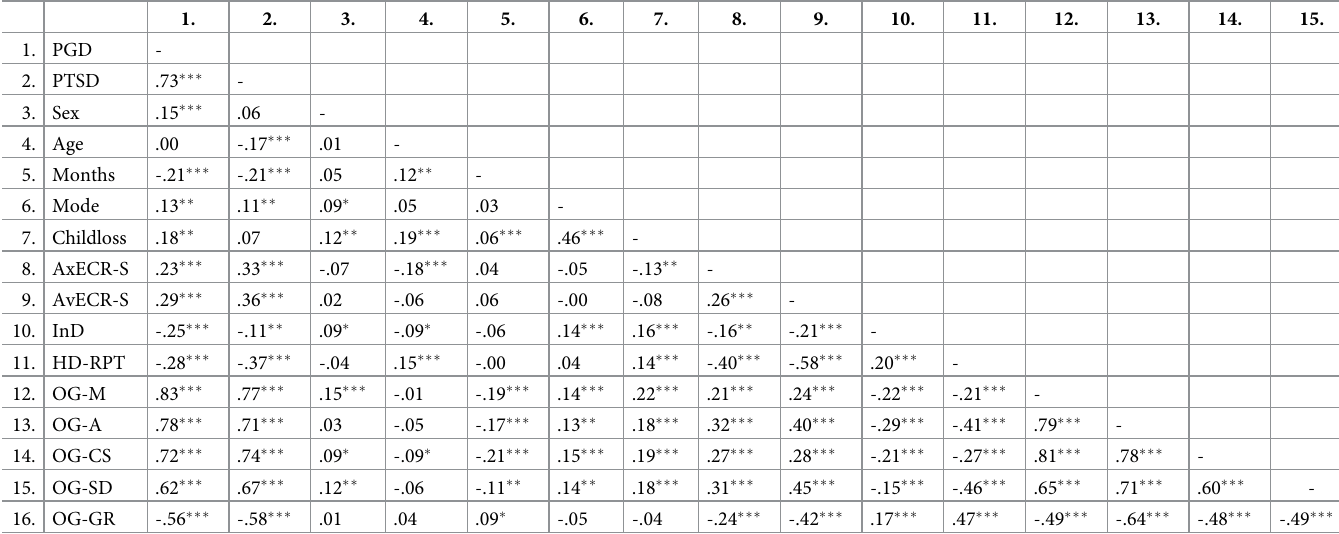
Table 2. Zero order correlations of PGD, PTSD, cognitive predictors, and pre-loss individual differences.